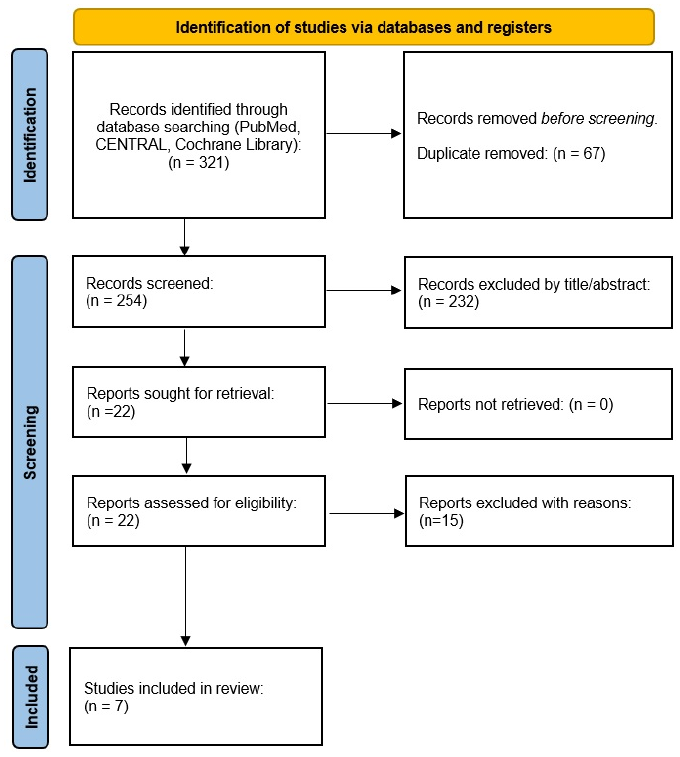
Figure 1. PRISMA flow diagram. From Page et al. [8].